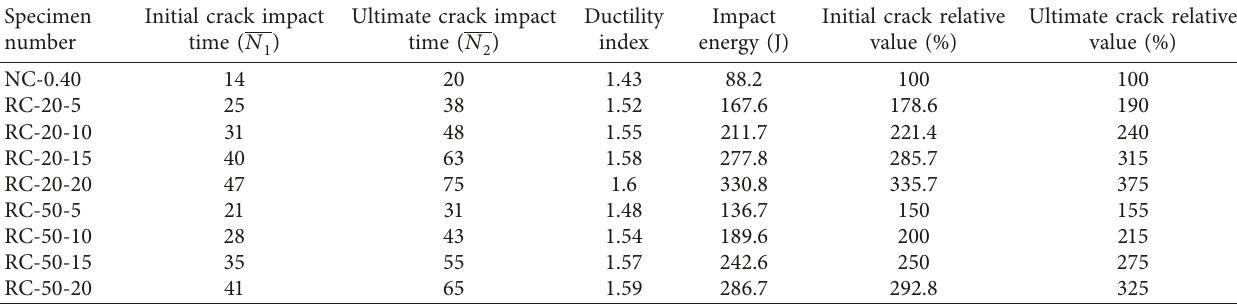
Table 8: Impact test results for the rubber concrete specimens at 25 ° C.